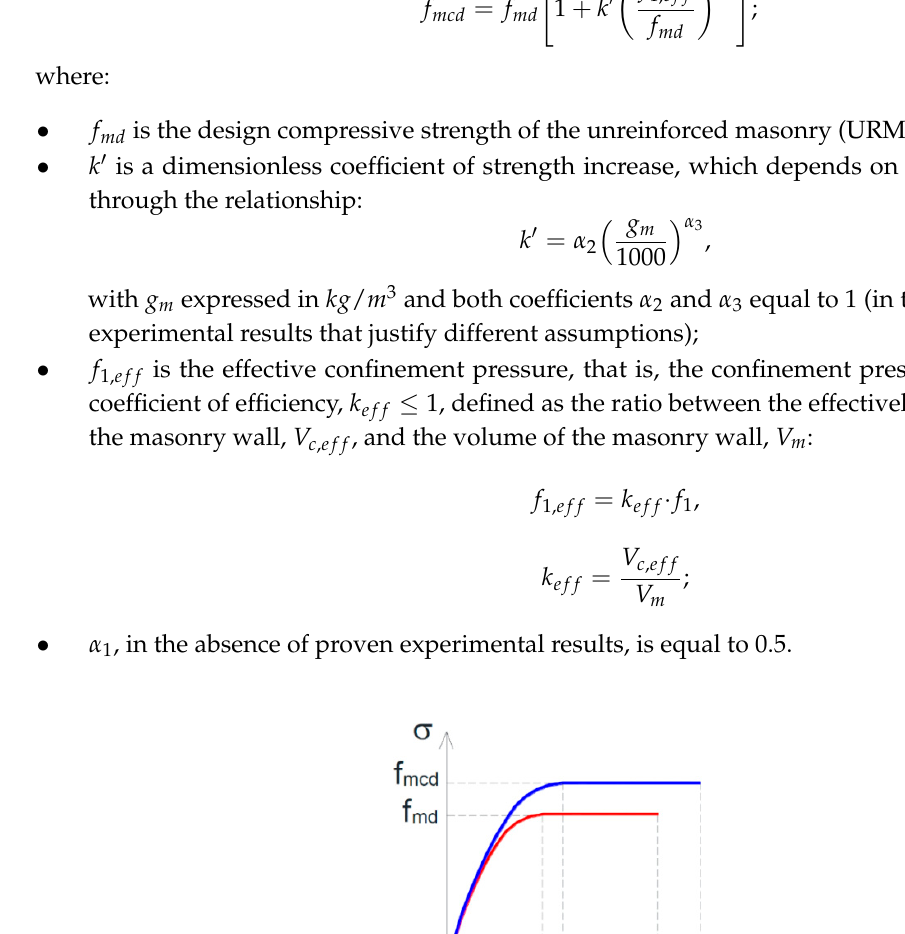
Figure 30. The cross ‐ sectional area that is effectively confined in a column reinforced by both external wrapping and internal bars [66].